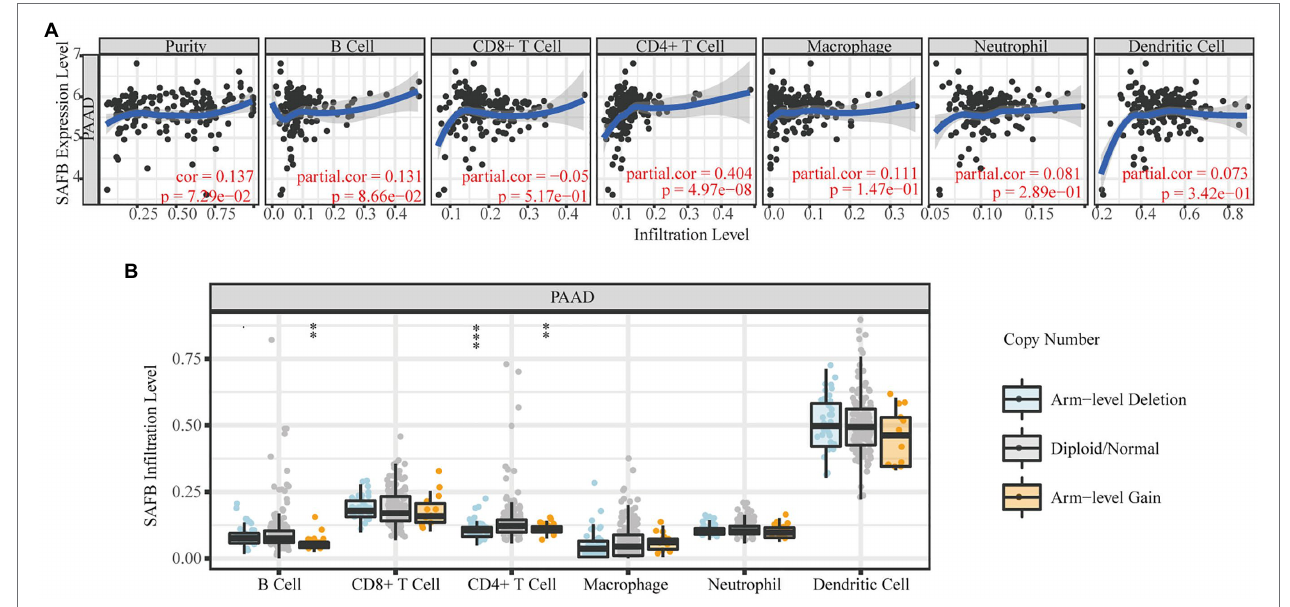
FIGURE 5 | The immunoregulatory effects of SAFB on the PAAD tumor microenvironment. (A) The relationships between SAFB expression and the abundance of six common immunocyte infiltrations in PAAD. (B) The relationships between somatic copy number alteration of SAFB and the abundance of six common immunocyte infiltrations in PAAD. * p < 0.05; ** p < 0.01; and *** p <